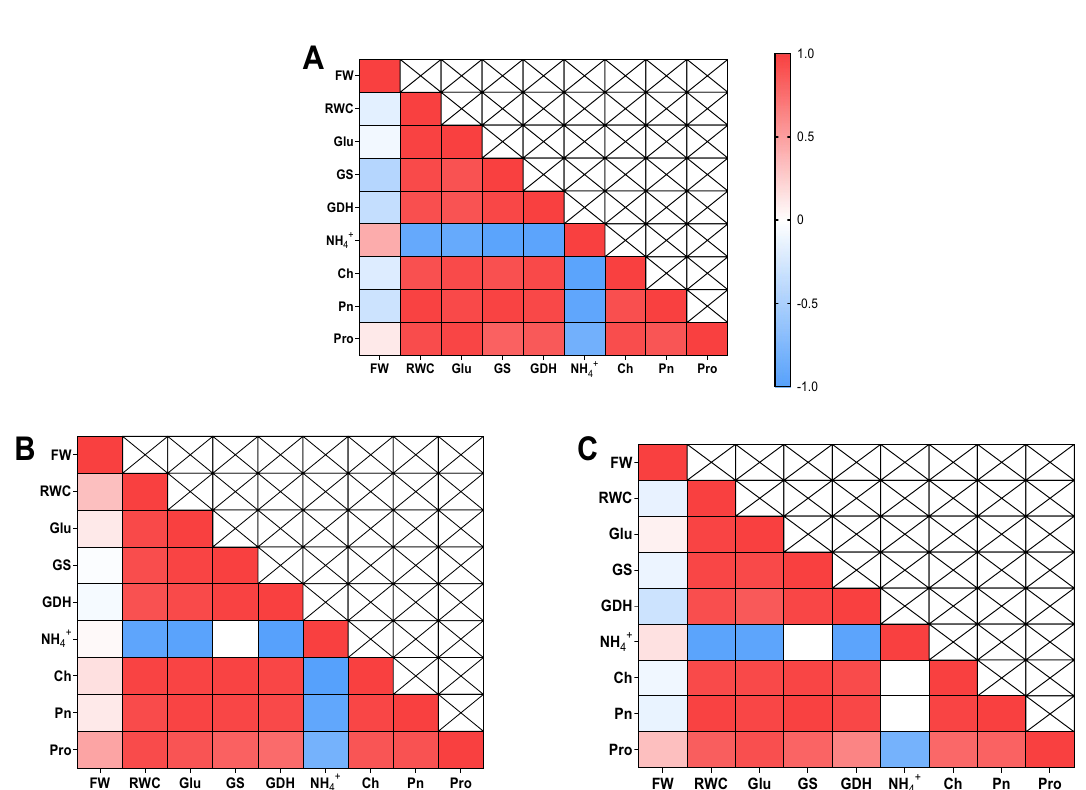
Figure 1. The correlation between physio-chemical traits of soybean leaf at S1 ( A ), S2 ( B ), and S3 ( C ) stages under drought